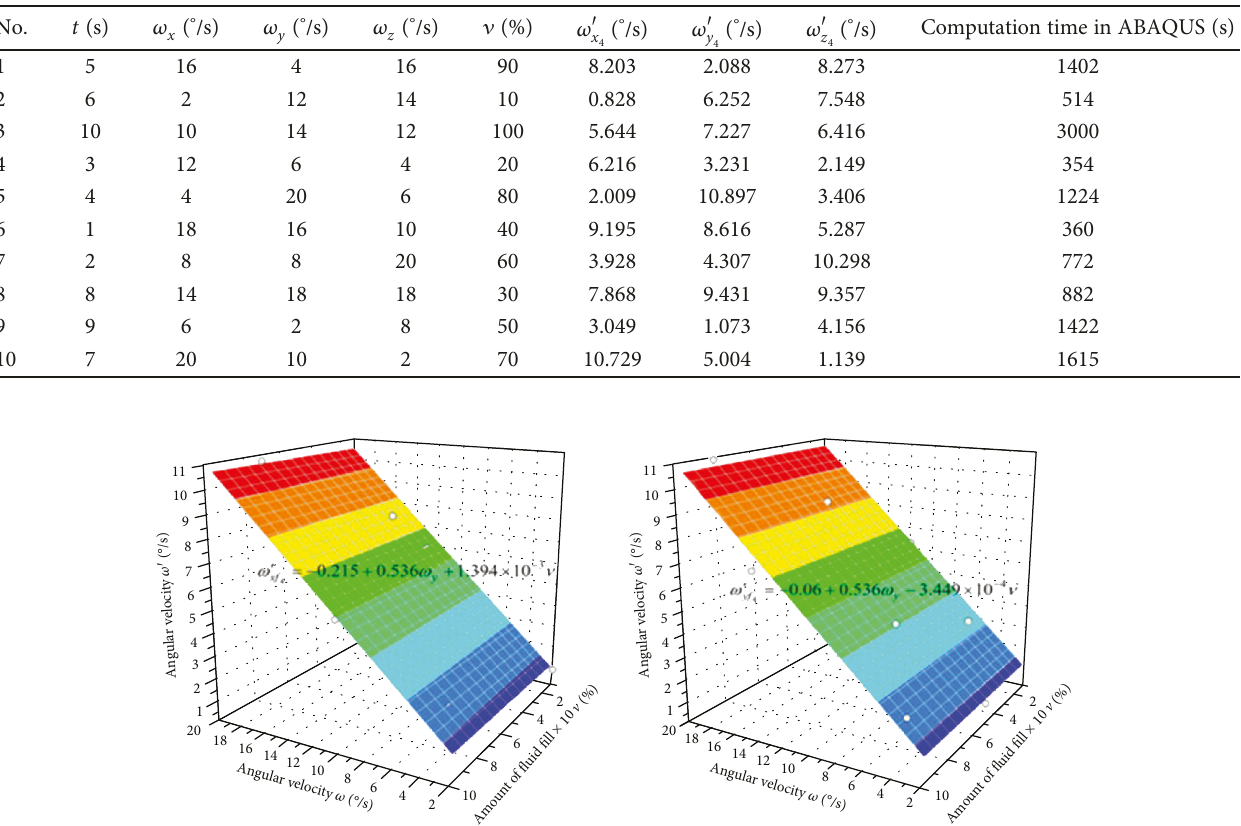
′ , ω ′ , and ω ′ of the surface regression equations. xf 4 yf 4 zf 4